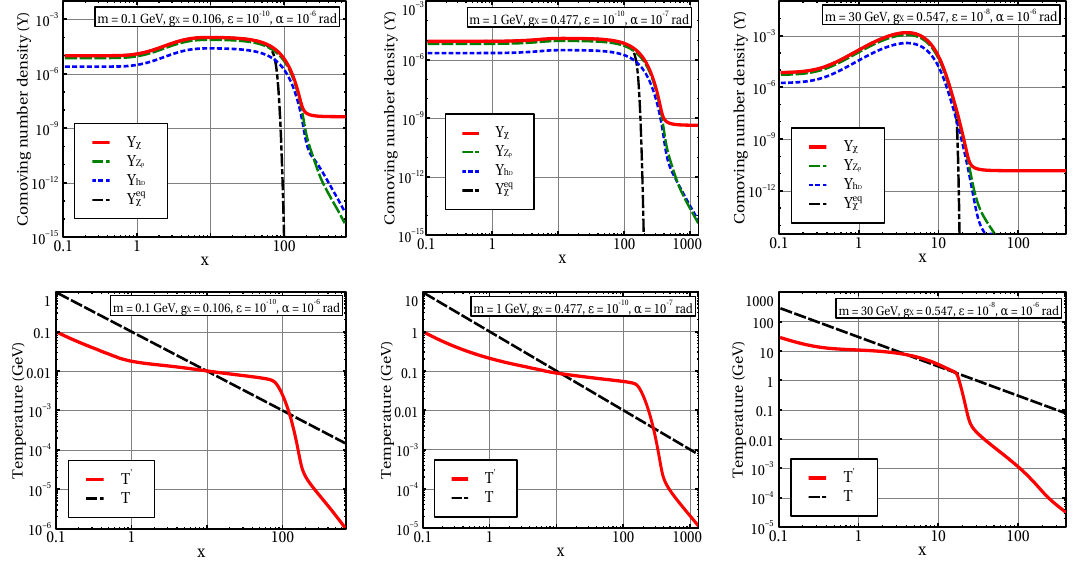
+ χ , Z 0 and h with x = m/T d 1 2